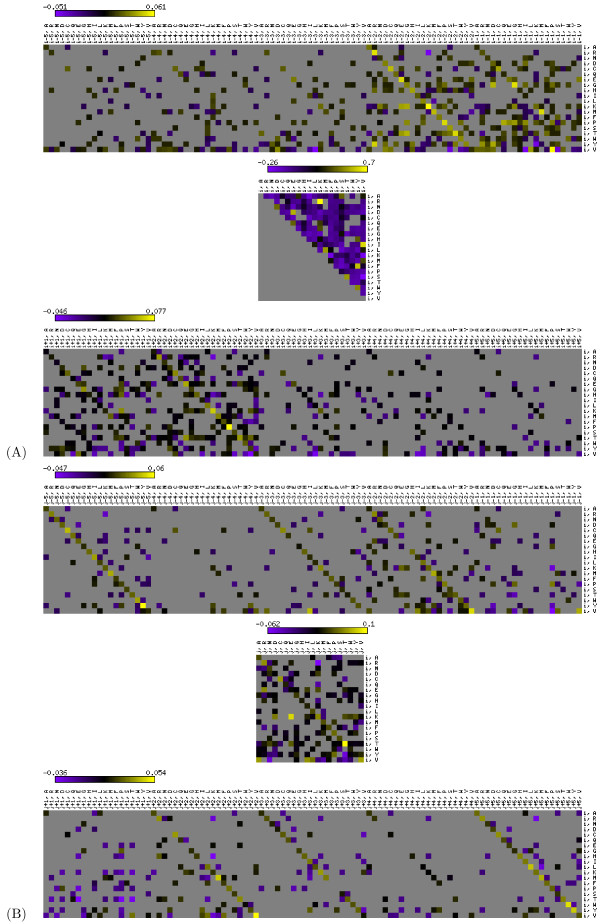
The learned dlink values for local and non-local positions in β strands. (A)The figure shows the dlink values learned from the real data for local correlations in β strands. The first plot illustrates the dlink values for the correlations between the ith position and the positions at i - LAA, ..., i - 1. The second plot depicts the dlink values for the correlations within the ith position. The third plot shows the dlink values for the correlations between the ith position and the positions at i + 1, ..., i + LAA. In each plot, rows represent the 20 amino acids for the observation vector at position i.(B) The figure depicts the dlink values learned from the real data for non-local correlations in β strands such that the β strand residues at positions i and j are known to make a bridge interaction. The first plot illustrates the dlink values for the correlations between the ith position and the positions at j - LAA, ..., j - 1. The second plot depicts the dlink values for the correlations between the ith position and the jth position. The third plot shows the dlink values for the correlations between the ith position and the positions at j + 1, ..., j + LAA. In each plot, rows represent the 20 amino acids for the observation vector at position i. In this experiment, LAA is chosen as 5 corresponding to a window of 11 residues. In both figures, gray colored bins represent dlinks that are not present in the resulting sparse model.